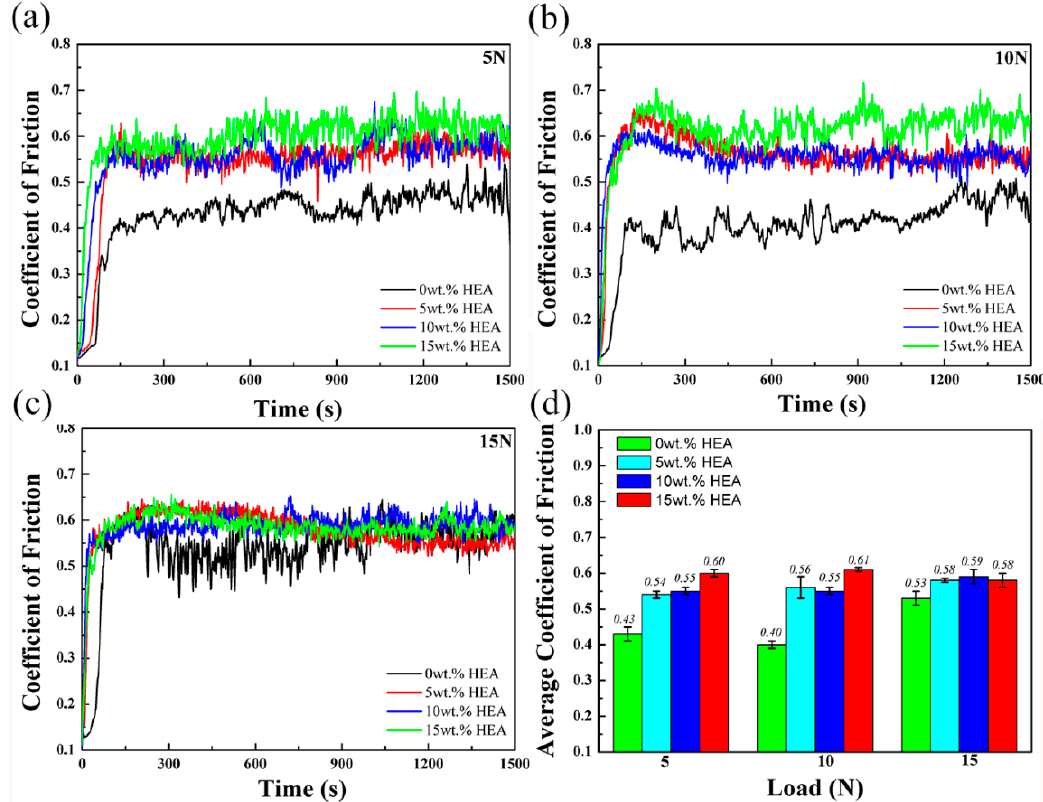
Figure 9. Coefficients of friction (COFs) under different loads: ( a ) 5N; ( b ) 10N; ( c ) 15N; and ( d ) average COFs.